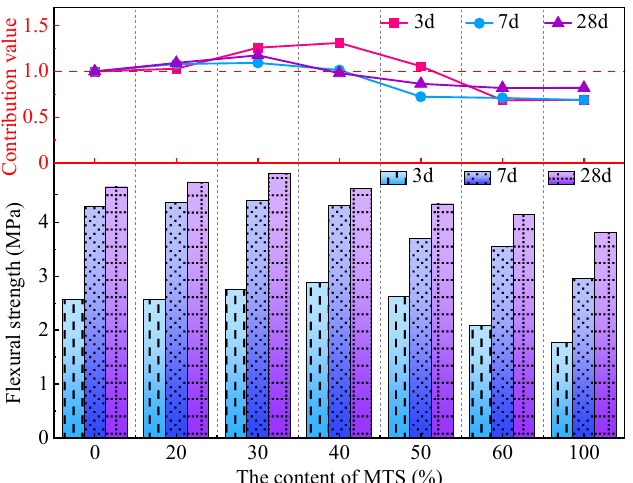
Figure 5. Effect of MTS content on flexural strength of MTSC and strength contribution value.